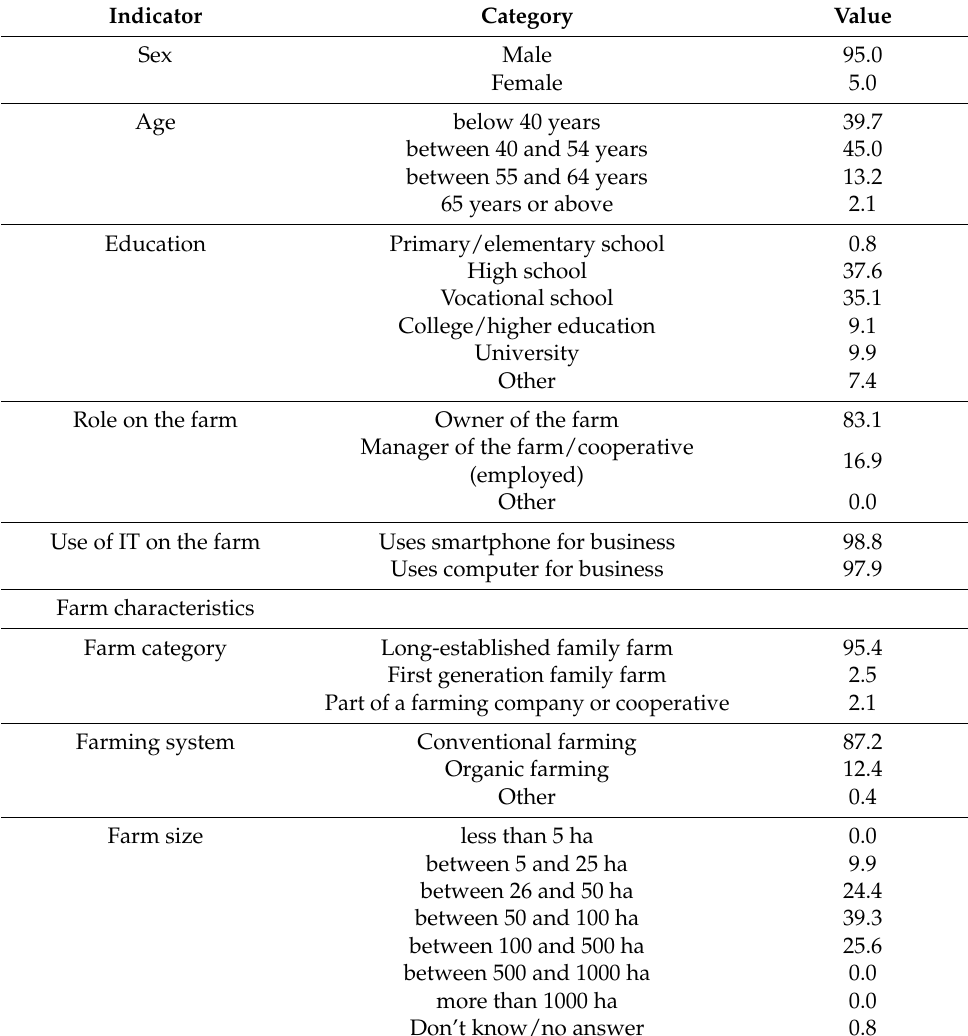
Table 3. Sample characteristics (percentages, except for last indicator), (the number of farmers that was interviewed) N =